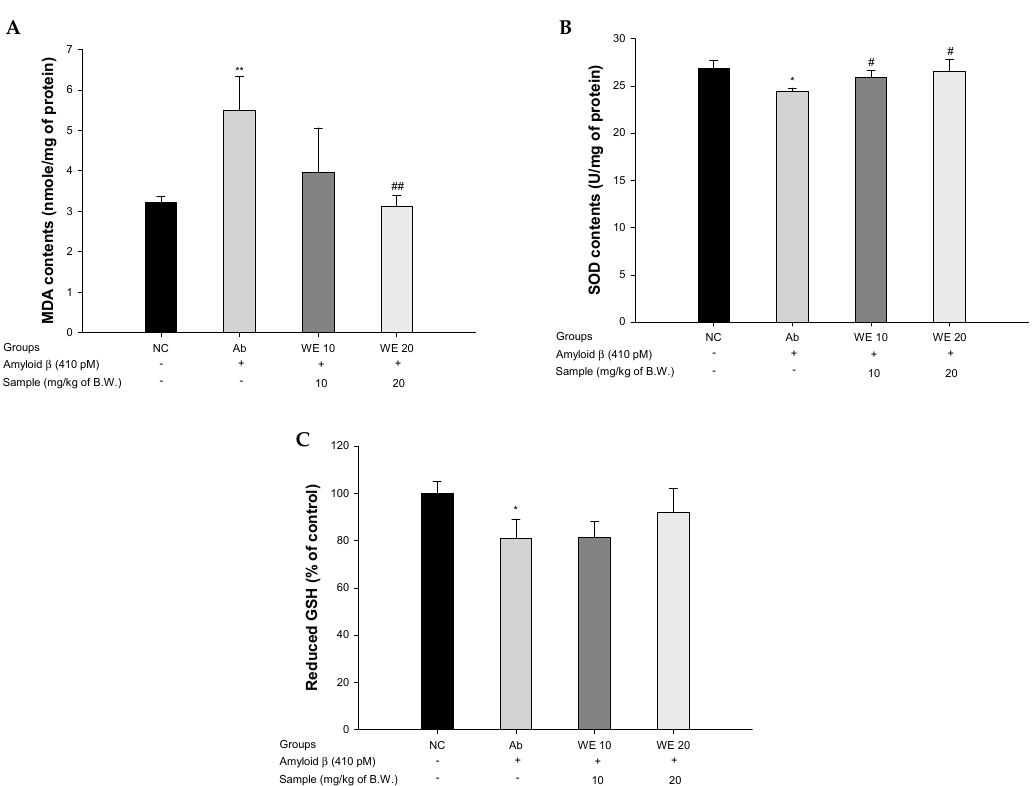
Figure 4. Protective effect of walnut ( Juglans regia L.) extract on A β -induced biochemical changes related with antioxidant systems: ( A ) malondialdehyde (MDA) levels, ( B ) superoxide dismutase (SOD) levels, and ( C ) reduced glutathione (GSH) levels in mice brain tissues. Results shown are means ± SD ( n = 5). Data are statistically represented at * = significantly different from the NC group; # = significantly different from Ab group; * and # p < 0.05, ** and ## p < 0.01.